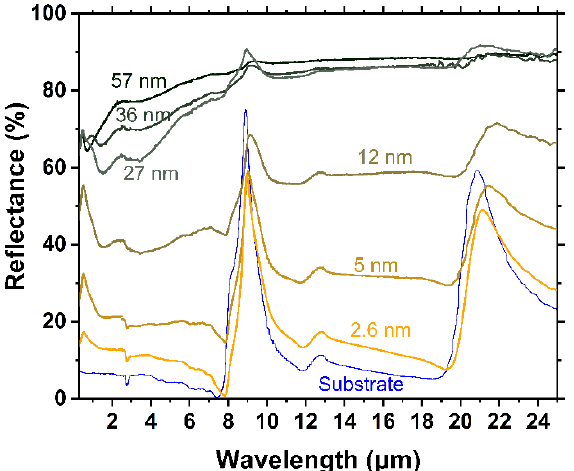
Figure 7. Ex situ UV-visible IR transmittance of bare fused silica substrate and of the samples with deposited Cr films of various thicknesses.